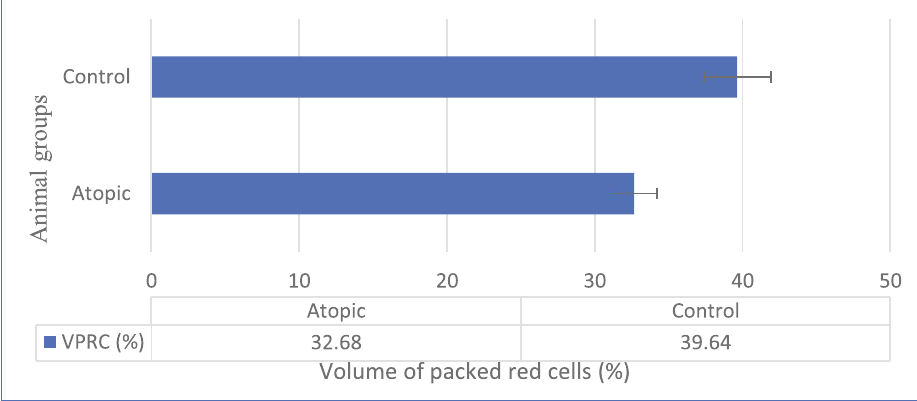
Fig. 3. Mean volume of packed red cells (%) in atopic animals and healthy controls table 2. Leucogram in atopic animals and healthy controls Variables Atopic (n=16) Healthy (n=10) t-value Total leukocyte count ( x 10 3